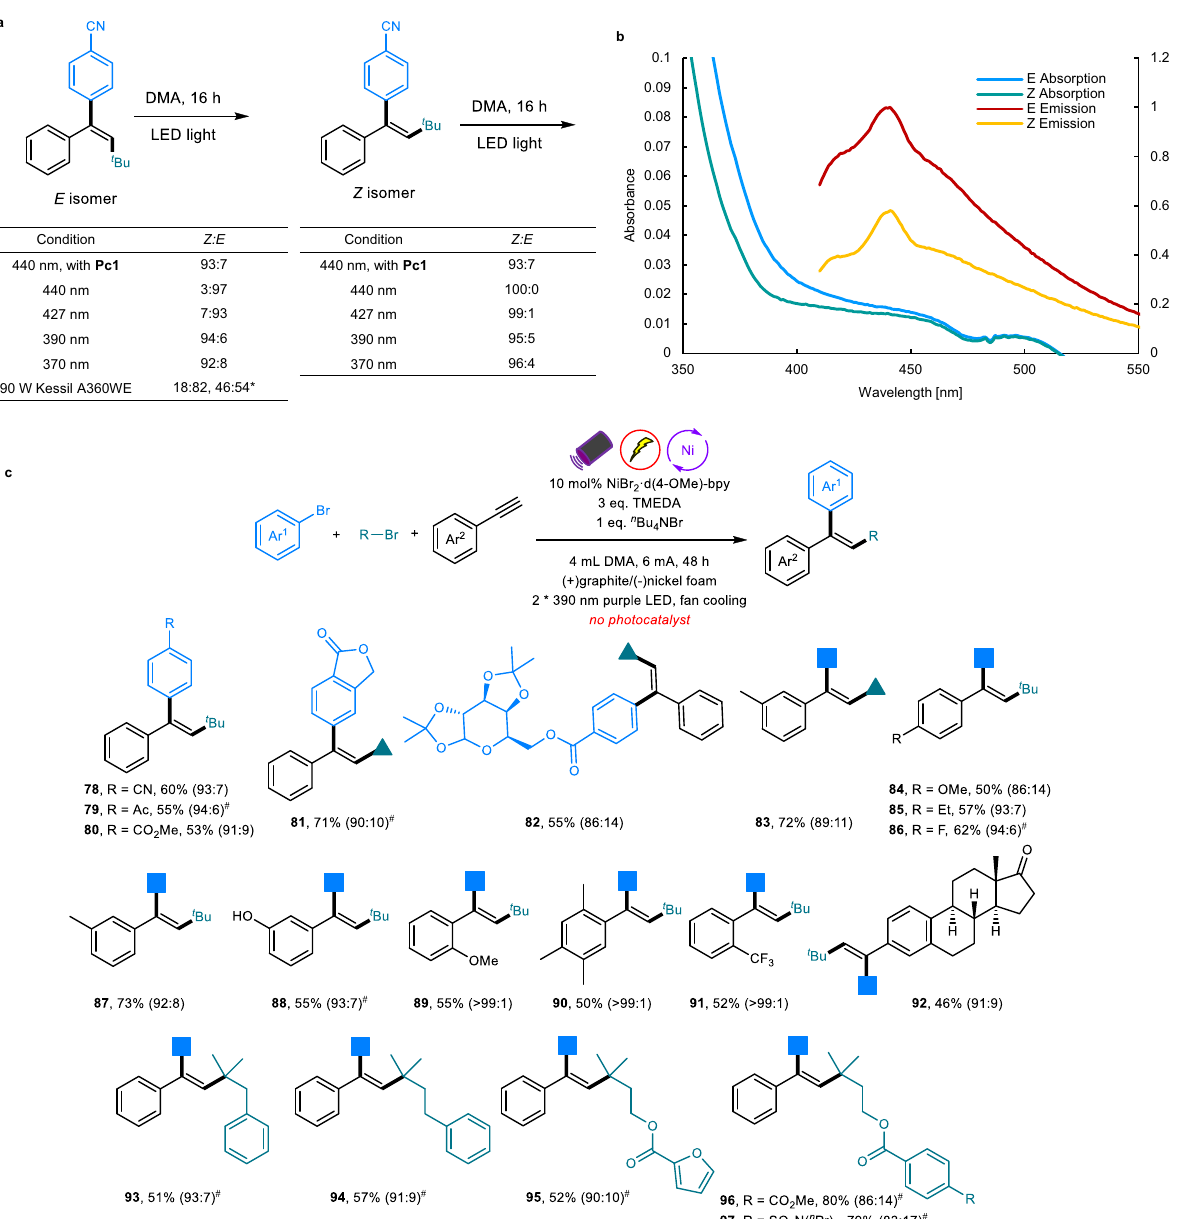
Fig. 4 Mechanistic study and scope of the photo-assisted electrochemically nickel catalyzed arylalkylation of alkynes. a Isomerization control reactions. b UV/Vis absorption spectroscopy and fl uorescence emission spectroscopy of E and Z isomers. c Reactions were performed with 0.2 mmol of aryl bromides, 0.4 mmol of alkynes, and 0.6 mmol of alkyl bromide. Yields are of the isolated products. The values in parentheses represent the ratio of the two isomers ( P syn : P anti ), which was determined by 1 H NMR analysis. *Reaction performed in DMSO. # Reaction conditions: aryl bromides (0.2 mmol, 1 equiv.), alkynes (0.4 mmol), alkyl bromides (0.6 mmol), NiBr 2 ·d(4-OMe)-bpy (10 mol%), TMEDA (3 equiv.), n Bu 4 NBr (2 equiv.) in 4 mL DMA and electrolysis